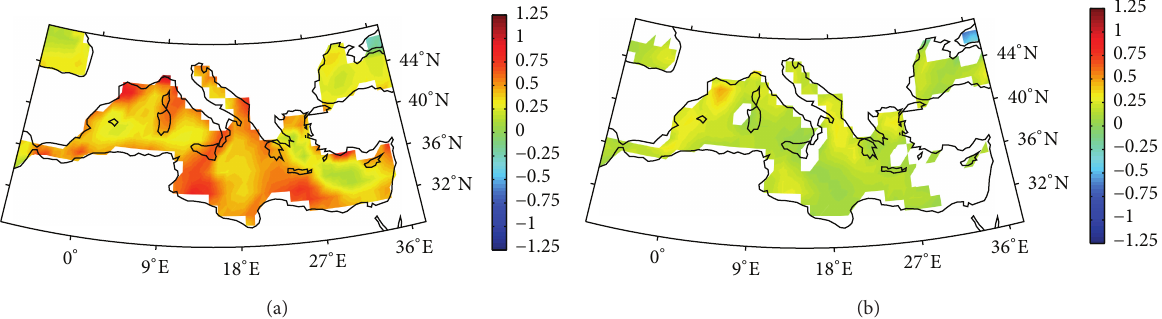
Figure 2: (a) Trends in DJF mean latent heat flux, 1958–2011 (Wm −2 /yr); (b) trends in DJF mean sensible heat flux, 1958–2011 (Wm −2 /yr). Only trends which are significant at 𝑃 = 0.05 are